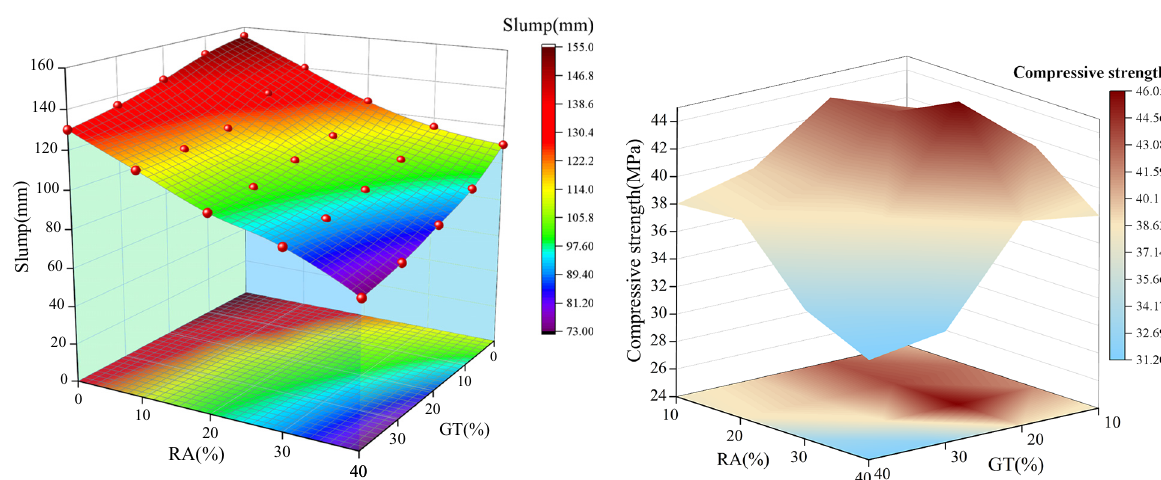
Figure 8: Compressive strength of